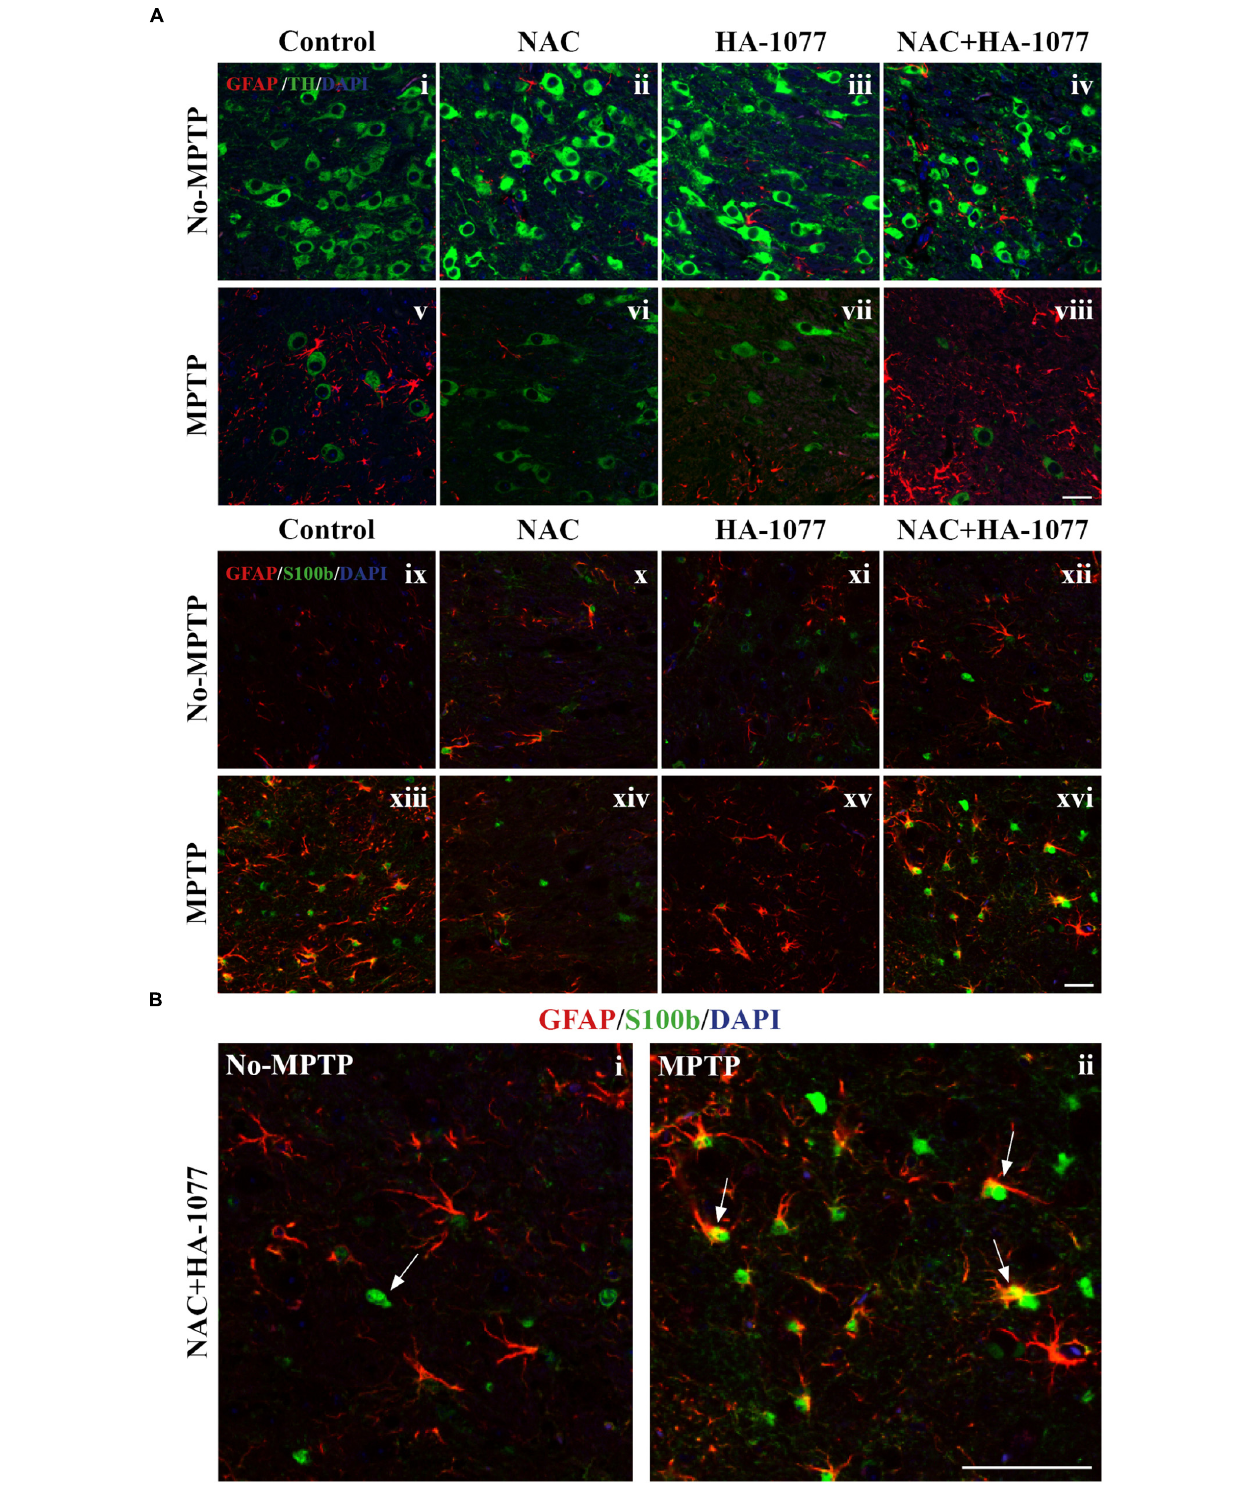
FIGURE 5 | Study of GFAP and S100b with TH in SNpc. (A) Representative micrographs of the double immunofluorescence assay for GFAP+TH (i–viii) and GFAP+S100b (ix–xvi) in the SNpc of the different experimental groups. (B) Representative figures for GFAP and S100b in the MPTP+NAC+HA-1077 group in which different astrocyte profiles were observed: S100b expressed in the nucleus and S100b co-located with GFAP in perinuclear cytoplasm. (Magnification 63 × , Scale bar = 50 µ m).